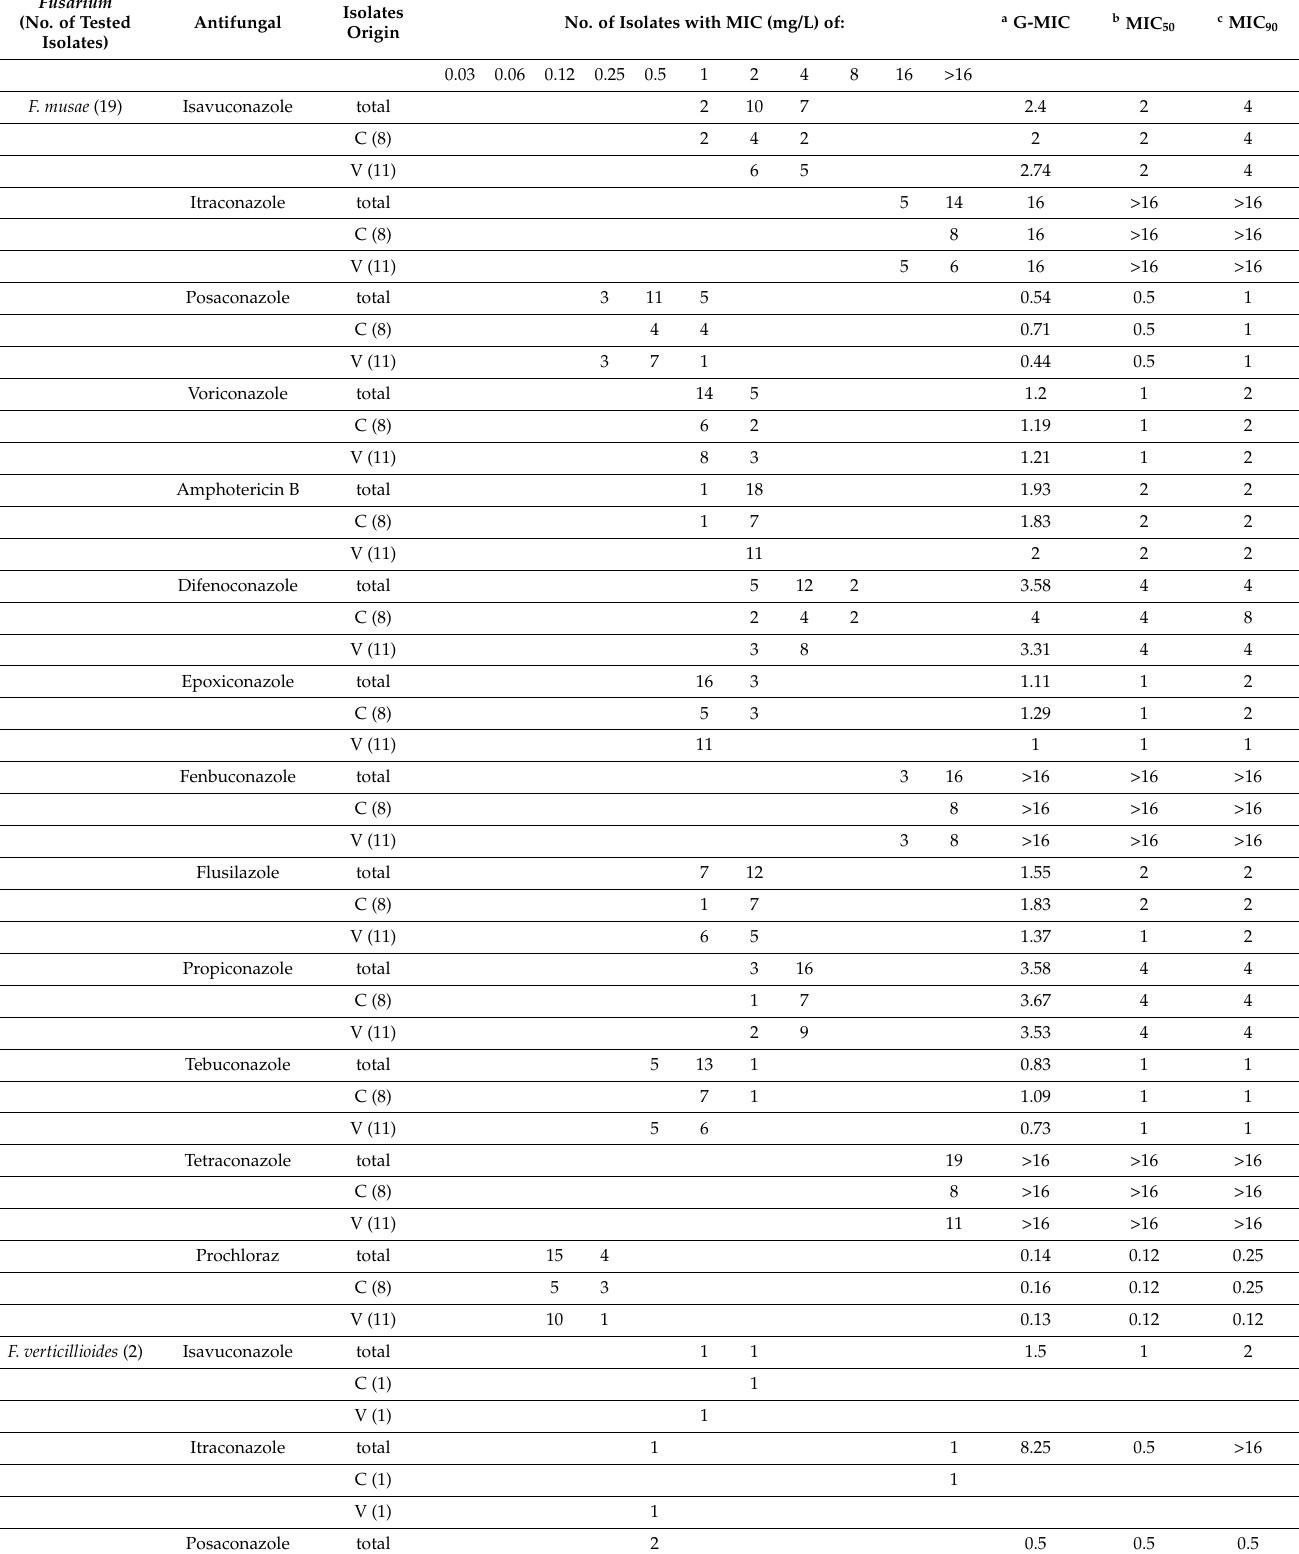
Table 2. In vitro susceptibility to antifungal drugs of the 21 Fusarium isolates determined by broth microdilution according to the Clinical and Laboratory Standards Institute (CLSI)